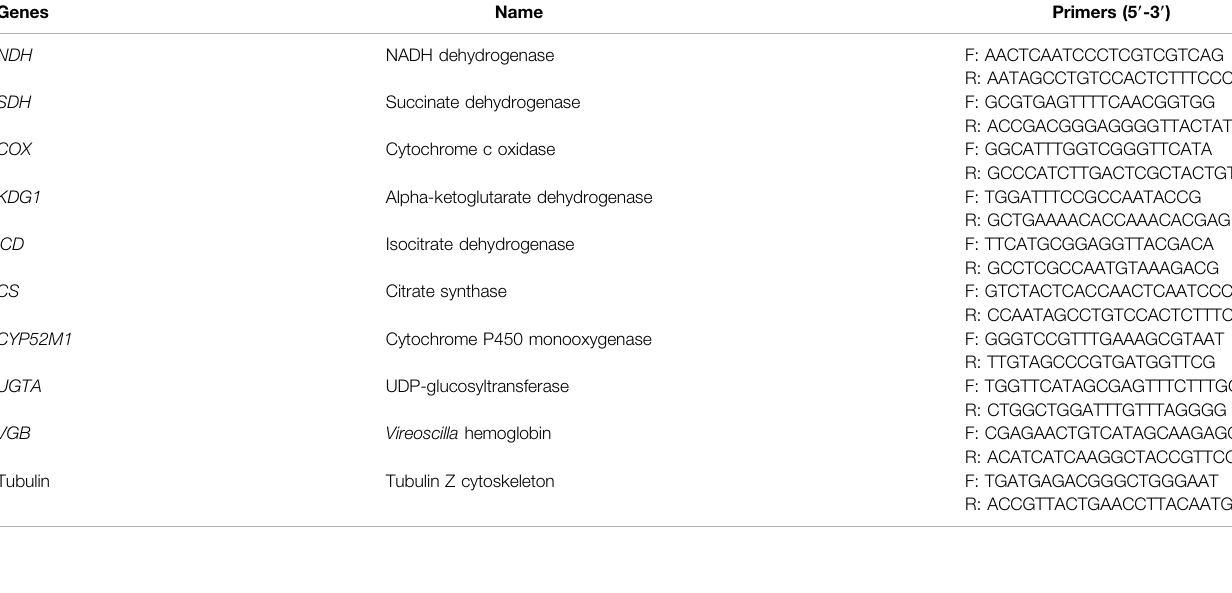
TABLE 2 | Primers and relevant information of reference and target genes for quantitative real-time PCR. Genes